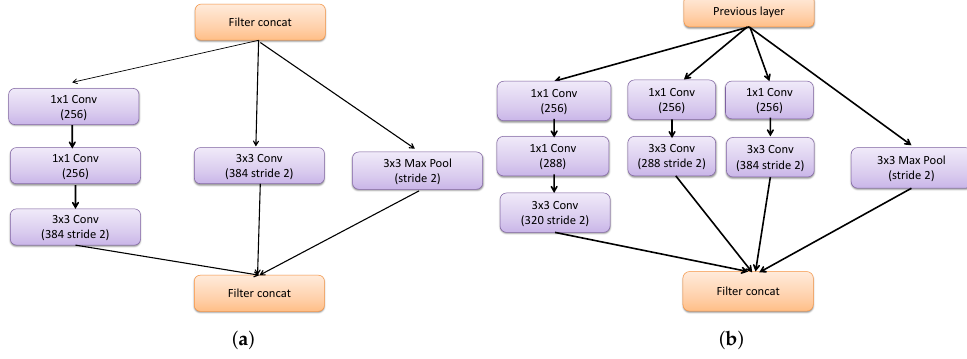
Figure 6. Reduction-A and Reduction-B modules ( a , b